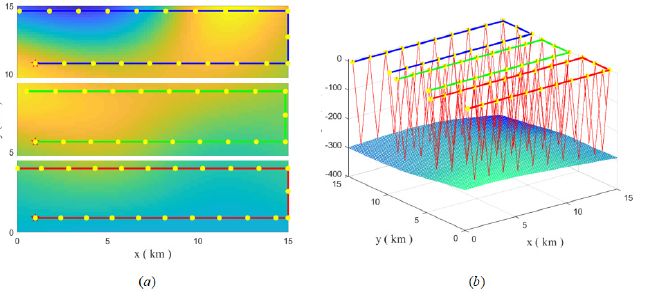
Figure 10. ( a ) The 2D plane trajectory of SCAN algorithm, ( b ) 3D space trajectory of SCAN algo-